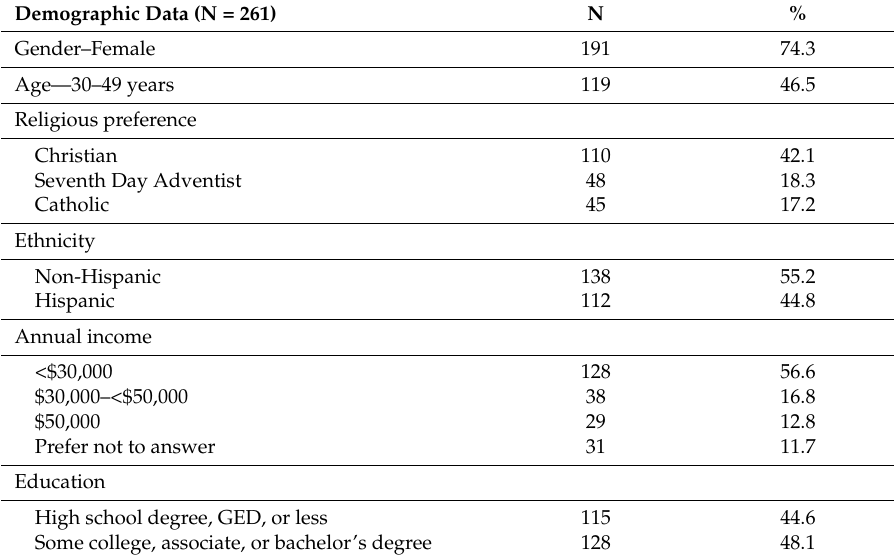
Table 1. Demographic